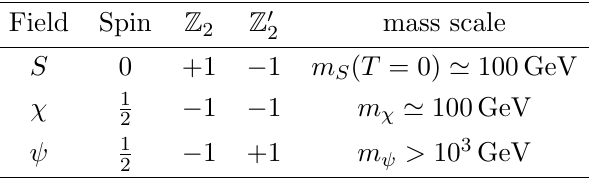
perature mass of S , m ( T = 0), and the quartic Higgs portal coupling (cid:21) . The pixelated p 4 S region shows where the two-step phase transition occurs. The colour coding quanti(cid:12)es the ratio of the DM abundance obtained including thermal corrections to the abundance if these corrections were neglected for a low T . We see that thermal e(cid:11)ects dominate the R abundance by up to four orders of magnitude. For (cid:12)xed m , they are largest at small (cid:31) m ( T = 0), where thermal corrections to m are most important, and at large (cid:21) , where p 4 S S the h S i 6 = 0 phase lasts longer. For a high T (cid:24) 10 TeV, the freeze-in abundance is dom- R inated by the S ! (cid:31) (cid:22) (cid:31) channel and thermal e(cid:11)ects dominate the abundance by around four orders of magnitude over the whole parameter space shown. In the white area at the top of (cid:12)gure 8, the global minimum of V e(cid:11) at T = 0 would be the one with h S i 6 = 0, i.e., electroweak symmetry would never be broken. In the white region at the bottom of the plot, S never acquires a non-zero